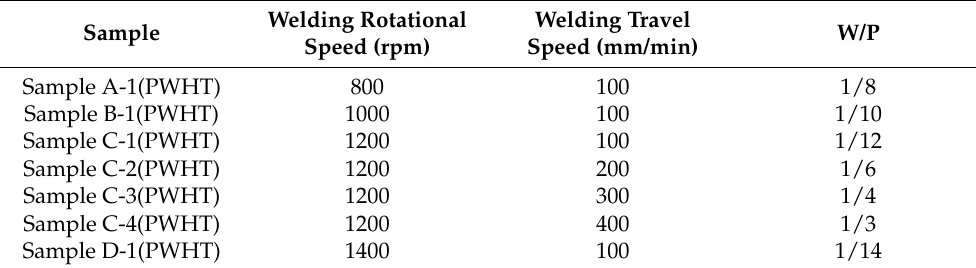
Table 3. Weld pitch under different welding